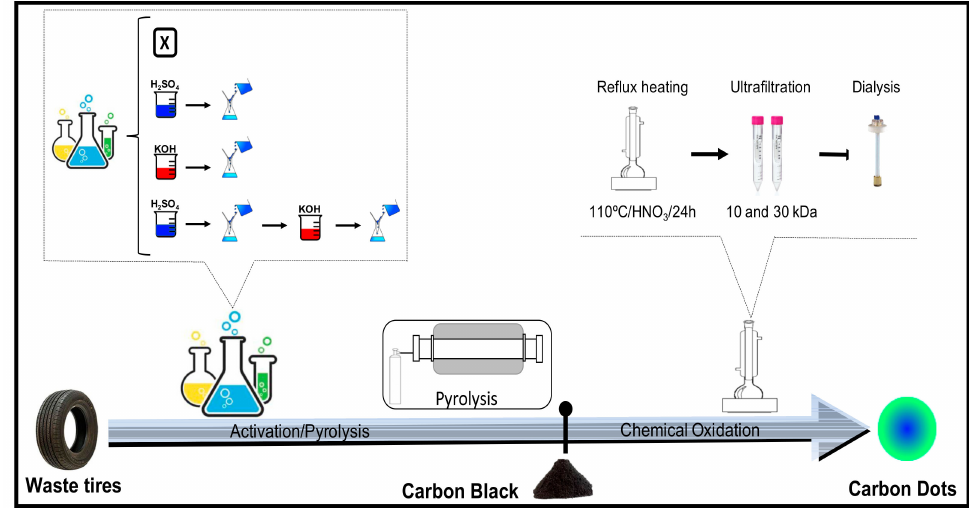
Figure 1. Methodology followed for the recovery of pyrolytic carbon black from waste tires and the synthesis of carbon